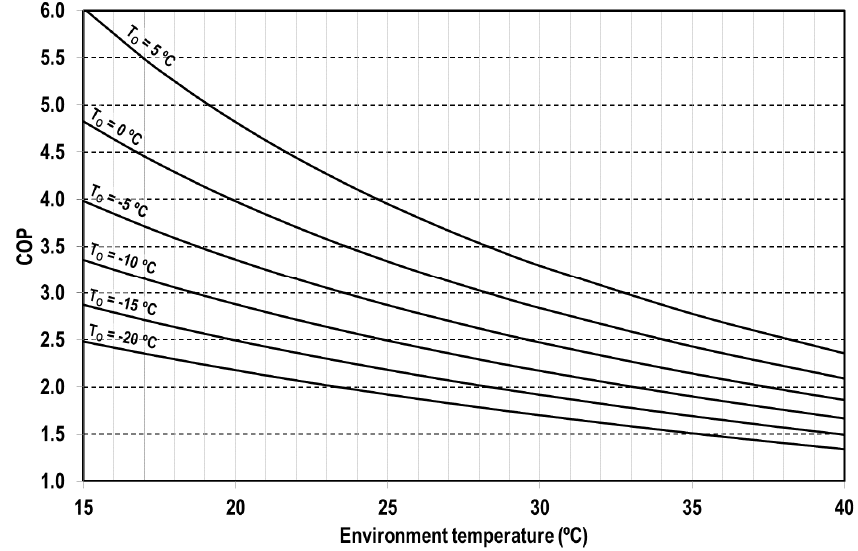
Figure 10. COP of the cascade cycle at optimum conditions.